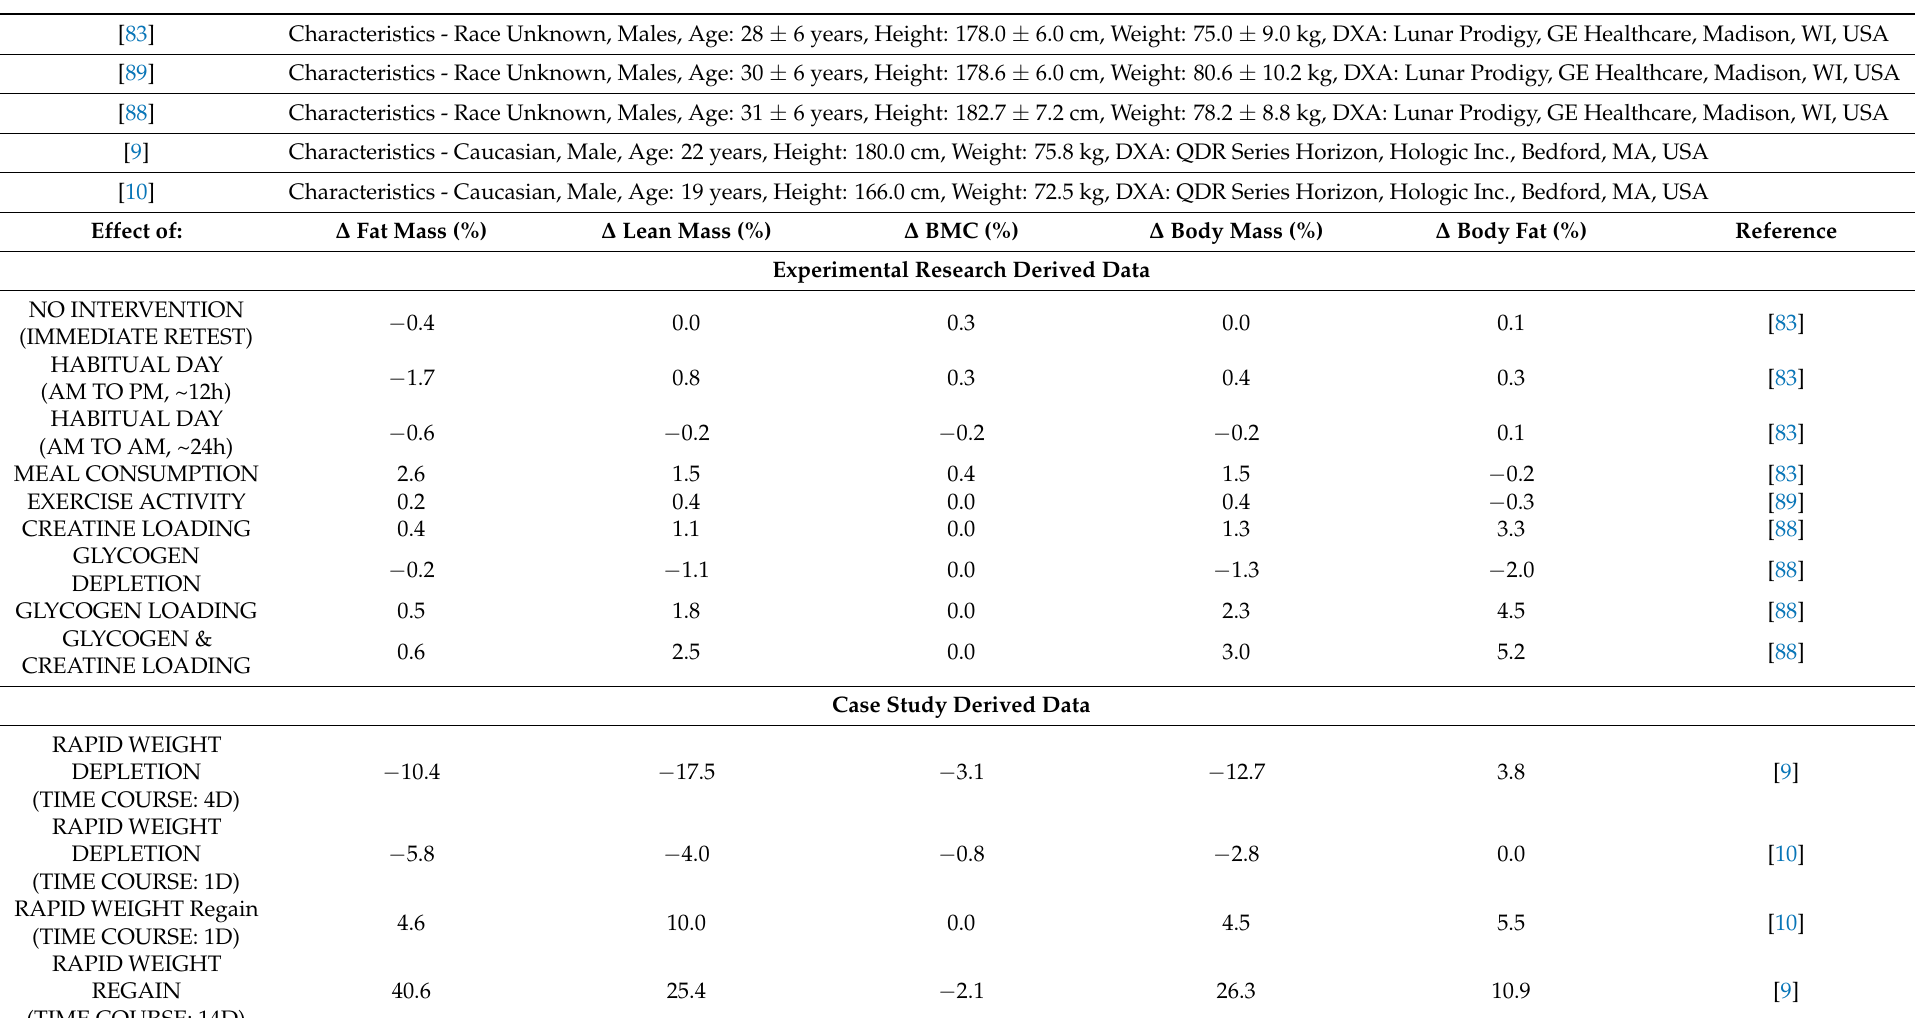
Table 4. A summary of differences in DXA scan results over the course of a habitual day [83]; following creatine supplementation [88]; exercise activity [89]; glycogen storage [88]; rapid weight loss and gain [9,10]; dual-energy X-ray absorptiometry (DXA); bone mineral content